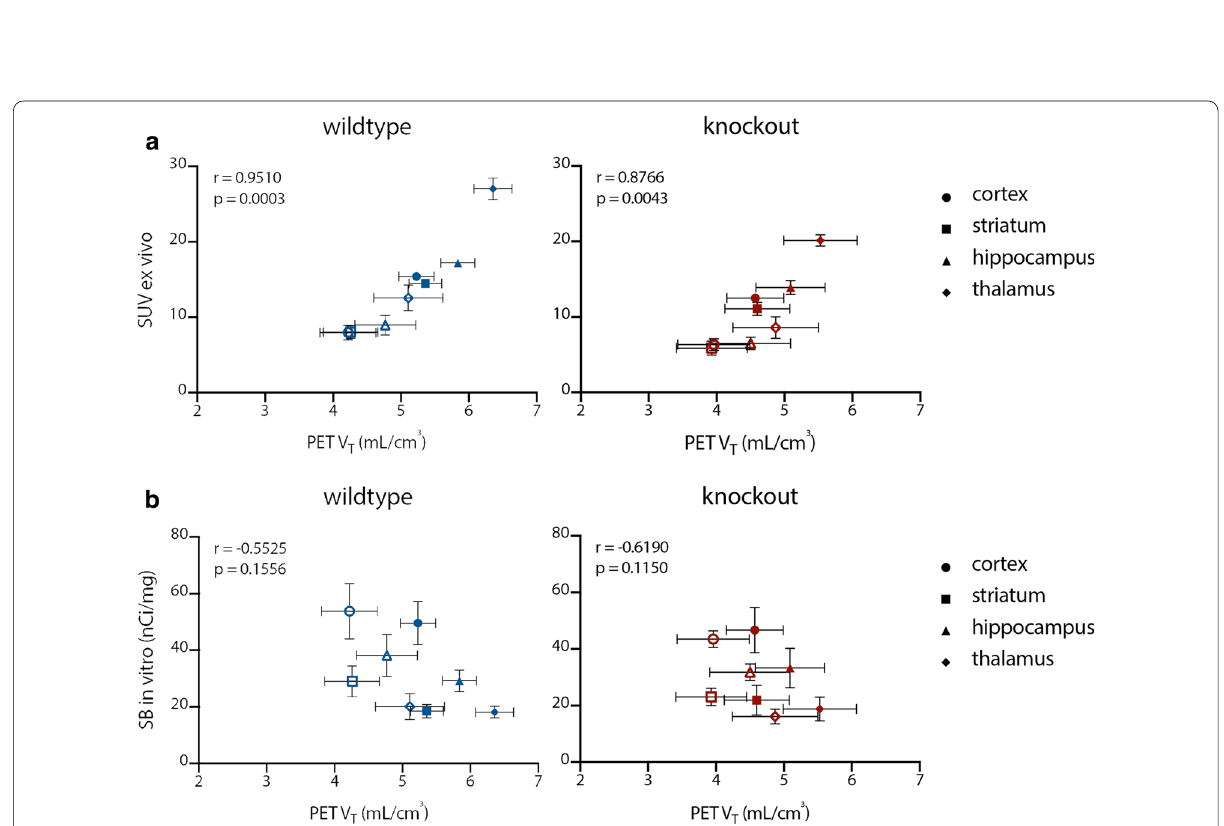
Fig. 5 The averaged [ 11 C]UCB-J µPET volume of distribution ( V T(IDIF) ) SD a versus the [ 11 C]UCB-J ex vivo autoradiography averaged standard ± uptake value (SUV) SD and b versus the [ 3 H]UCB-J in vitro autoradiography averaged specific binding (SB) for both genotypes. Three-mo data are ± depicted as filled symbols, while 9-mo data are depicted as open